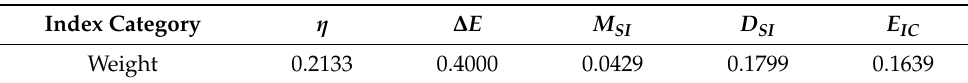
Table 9. Judgmental weight of THPSF.